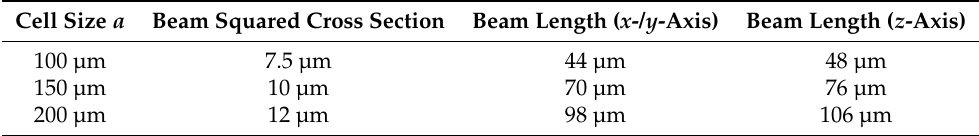
Table 1. Geometrical parameters of the fabricated structures.